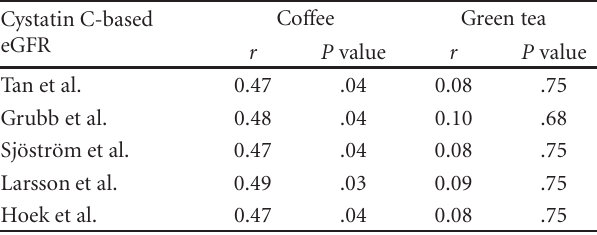
Table 4: Correlation coe ffi cients between changes in cystatin- C-based eGFR (determined using five di ff erent equations) and changes in serum magnesium between the start and end of each consumption period.